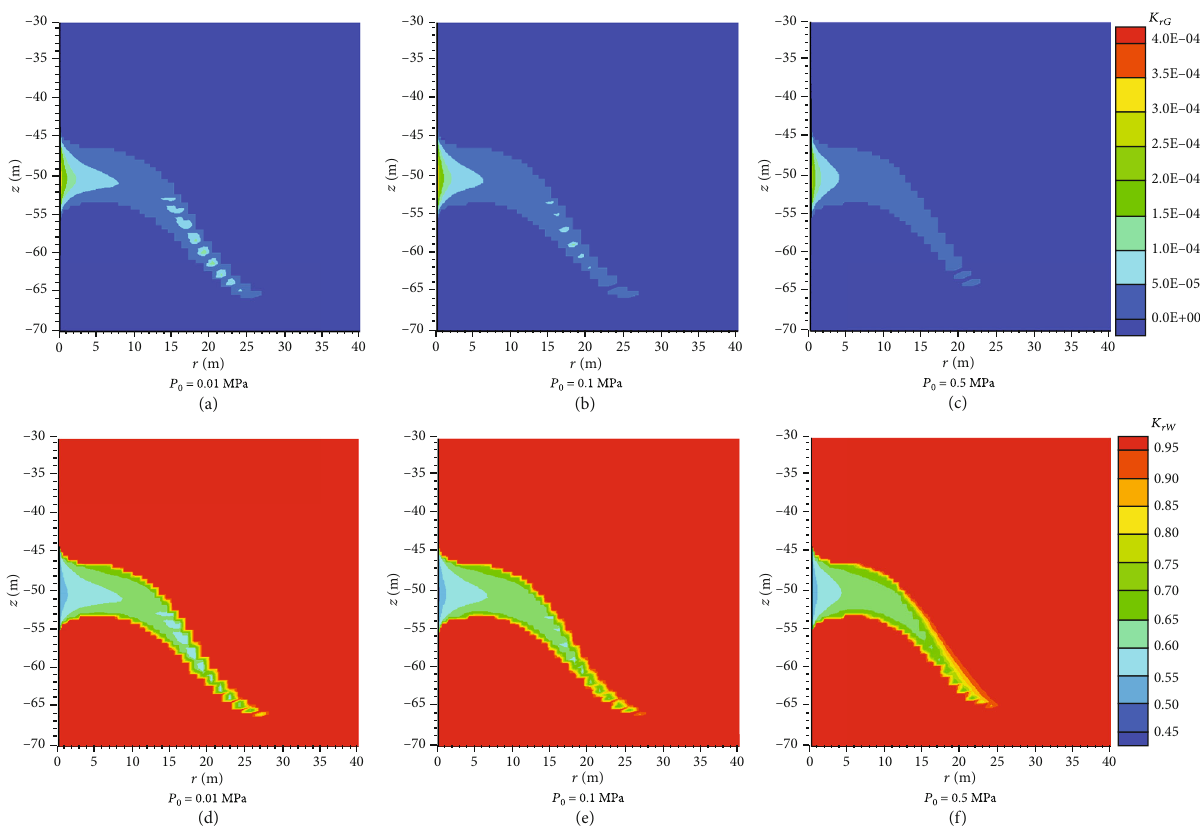
Figure 18: Comparison of gas relative permeability K gas entry pressure P 0 on the 3650 th